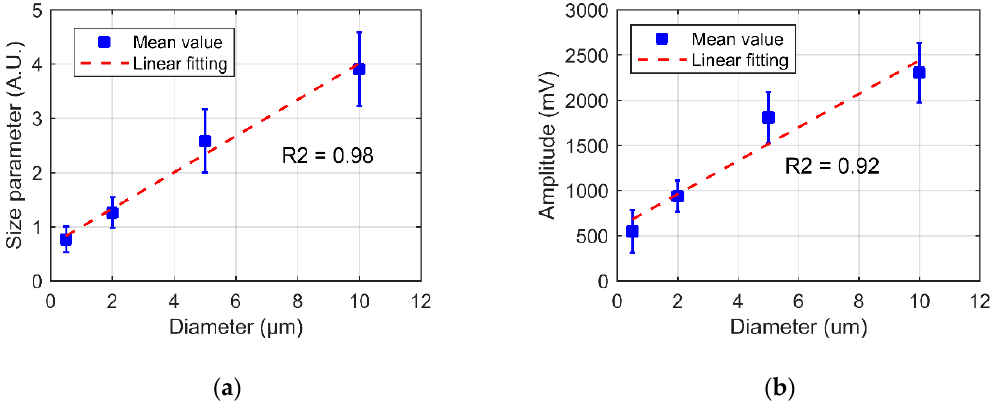
Figure 8. The histogram of the PS beads measurements. ( a ) Size parameter K. ( b ) SMI signal amplitude.